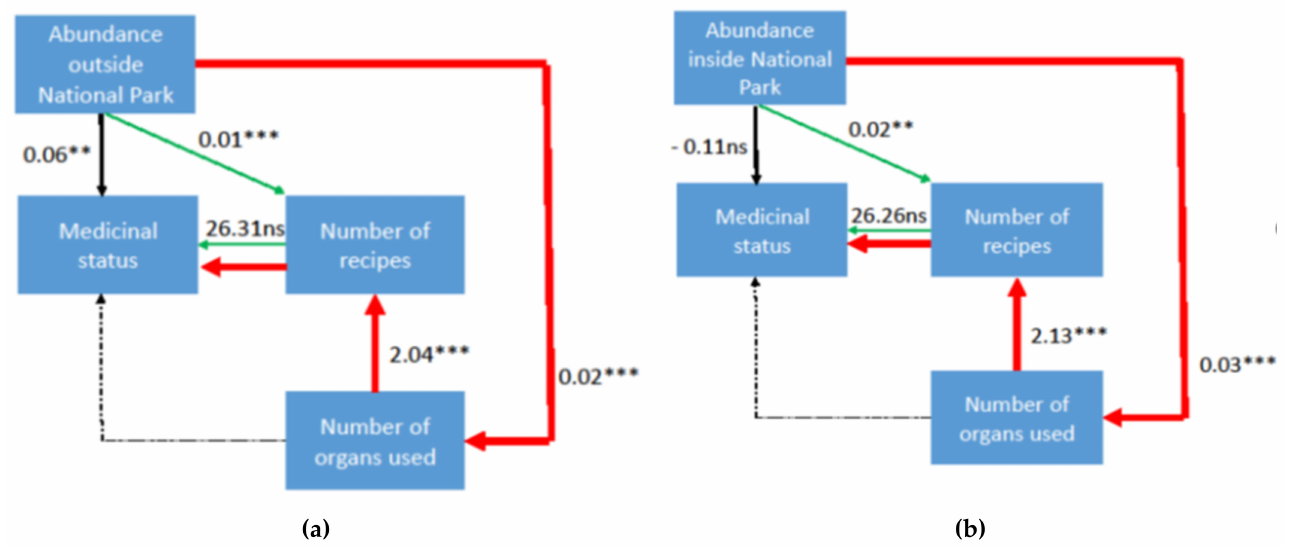
Figure 2. Meta-model illustrating the potential influence of plant abundance outside ( a ) versus inside ( b ) the Kruger National Park. Different paths (arrows) of the relationships of total abundance with medicinal status are color-coded; black, direct path, green, shortest indirect path, and red, longest and most strong indirect path. The width of arrow is indicative of the strength of the relationships between two variables. Values on the arrows are path coefficients. The number of stars indicates the level of statistical significance.